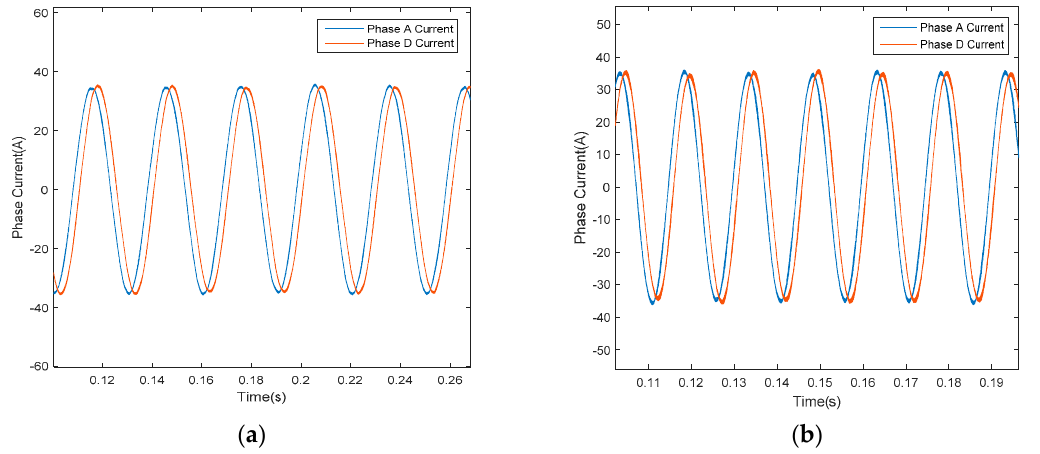
Figure 18. THDs of the phase A current after adopting the proposed resonant controller only, ( a ) speed is maintained at 500 rpm, and ( b ) speed is maintained at 1000 rpm.